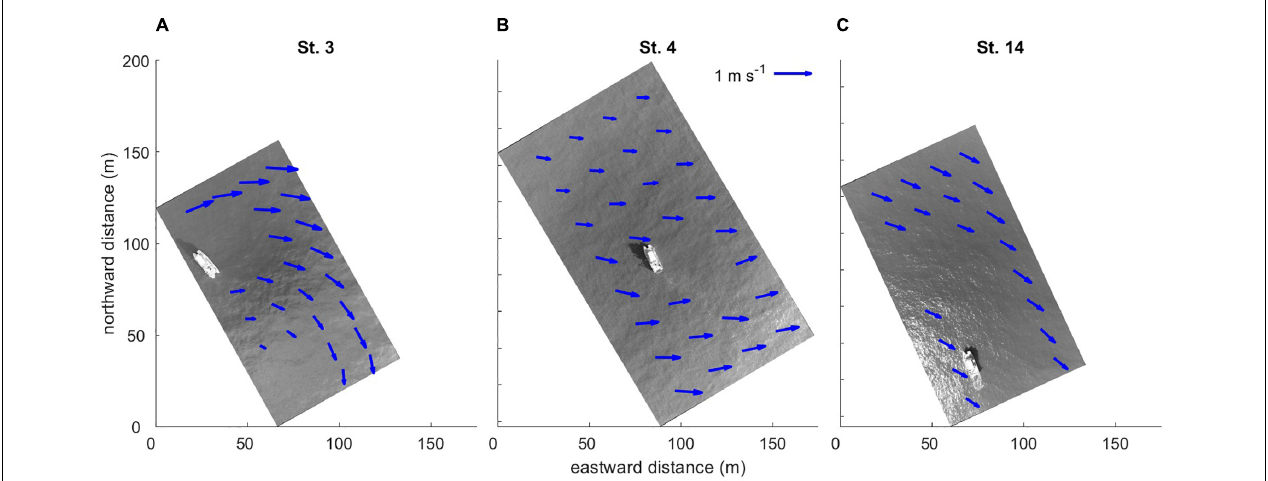
FIGURE 7 | Examples of drone-derived near-surface velocity field at (A) station 3; (B) station 4; (C) station 14.